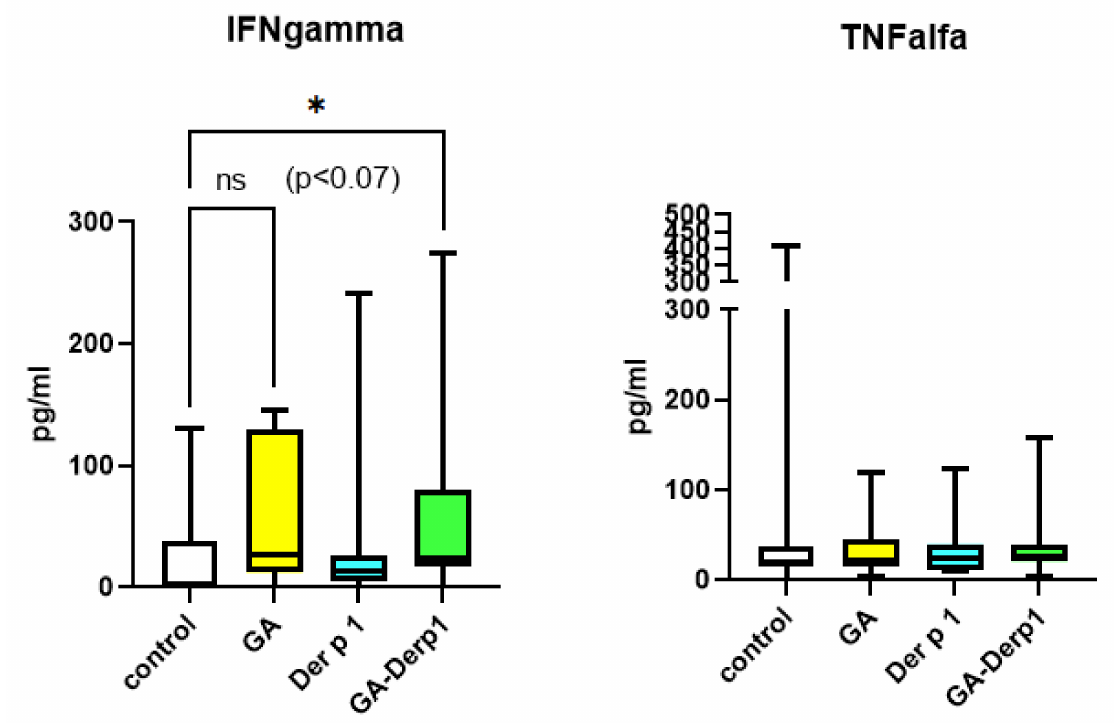
Figure 7. Spontaneous cytokine production by PBMCs cultured in the presence of the GA–Der p 1 complex or its components. Data are presented as box-and-whisker plots, with boxes extending from the 25th to the 75th percentile, with a horizontal line at the median, while the whiskers extend to the lowest and highest data points (n = 7); * Indicates a significant difference ( p <